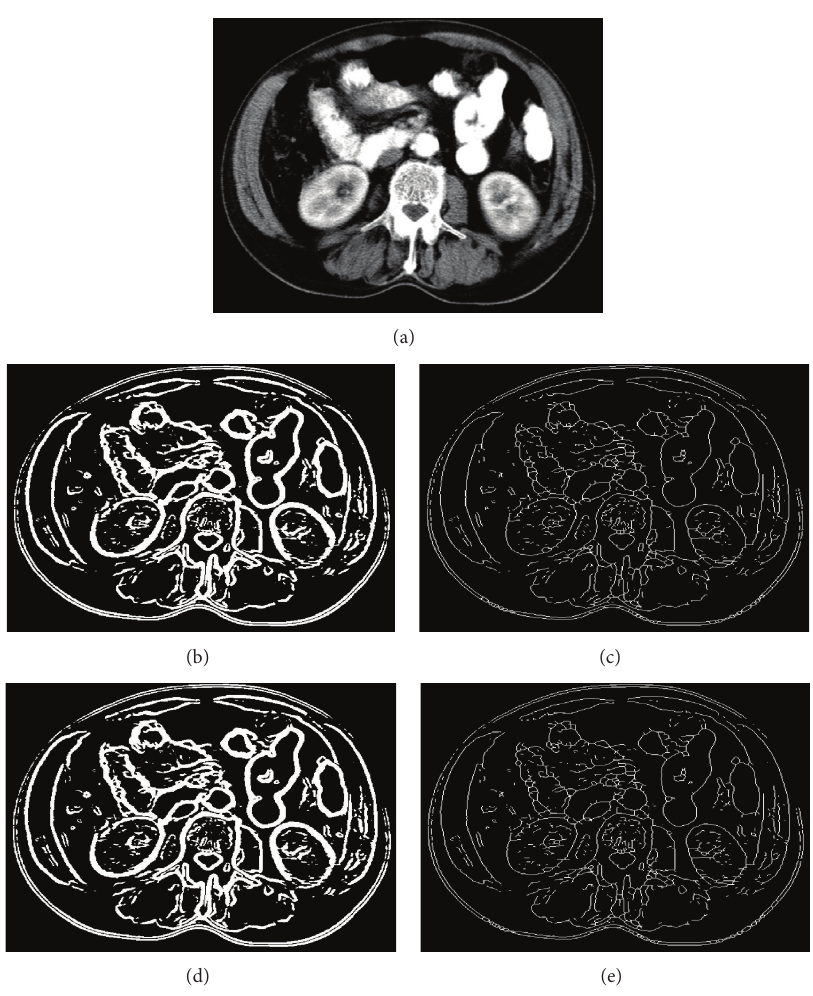
Figure 5: Edges of an abdominal CT image (𝜎 = 0.18 and 𝜔 = 0.0005) ; (a) original, (b) 𝑘 -means, (c) skeleton of (b), (d) FCM, (e) skeleton of